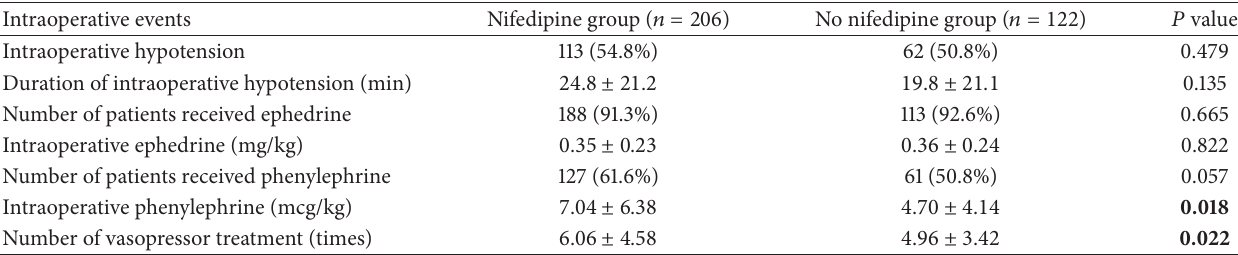
Table 2: Effect of preoperative nifedipine exposure on intraoperative